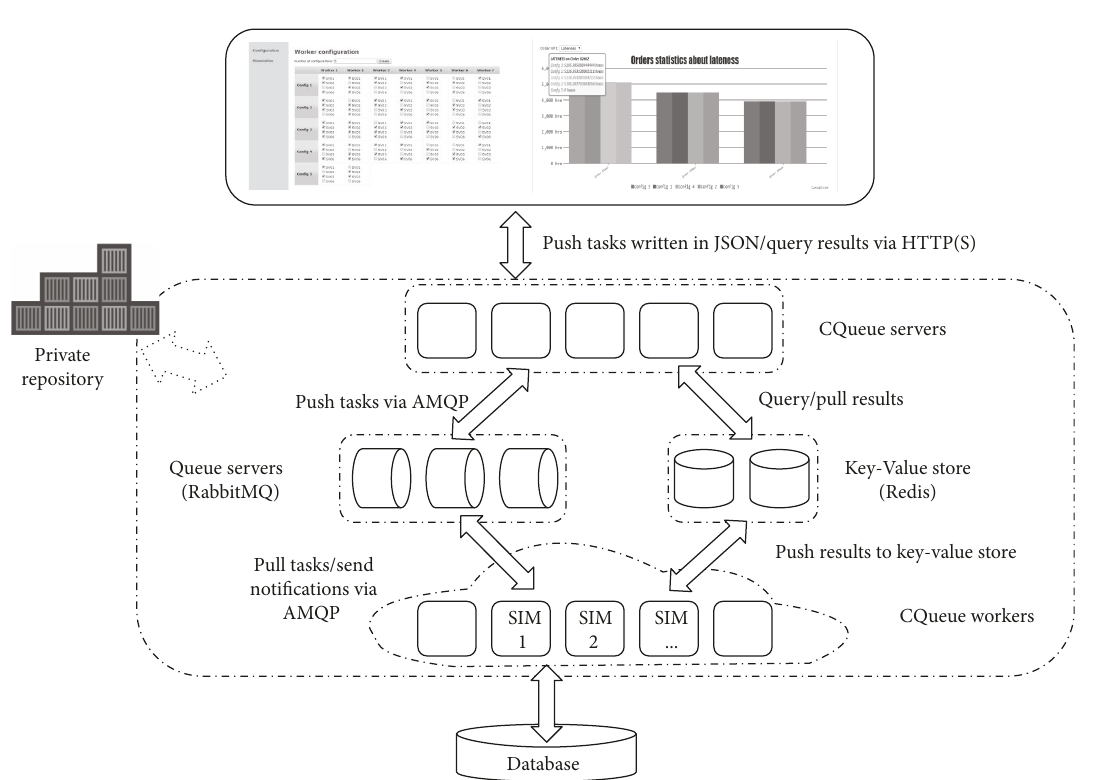
Figure 6: CQueue architecture in the context of